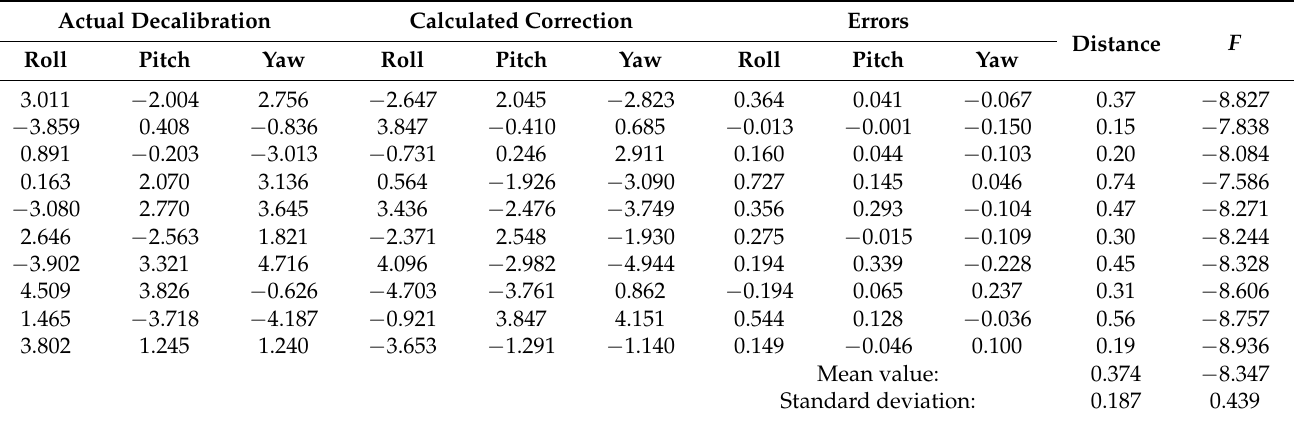
Table 1. Simulation of 10 decalibration experiments during car movement. Each row of the table corresponds to one experiment: F was optimized using the 50 most recent frames (different for each decalibration); 10 times, from 10 starting